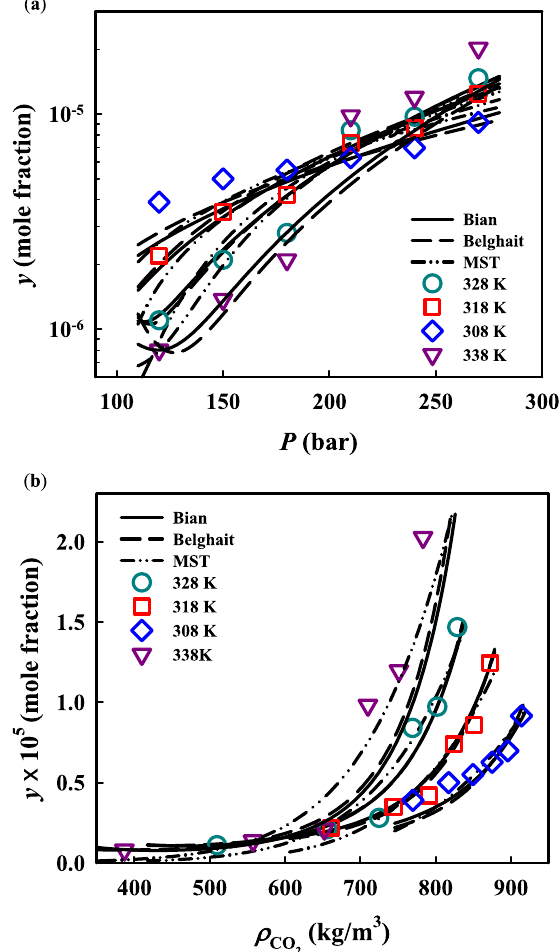
Figure 2. Palbociclib solubility in ScCO 2 versus ( a ) pressure and ( b ) density from experimentation and three semi-empirical